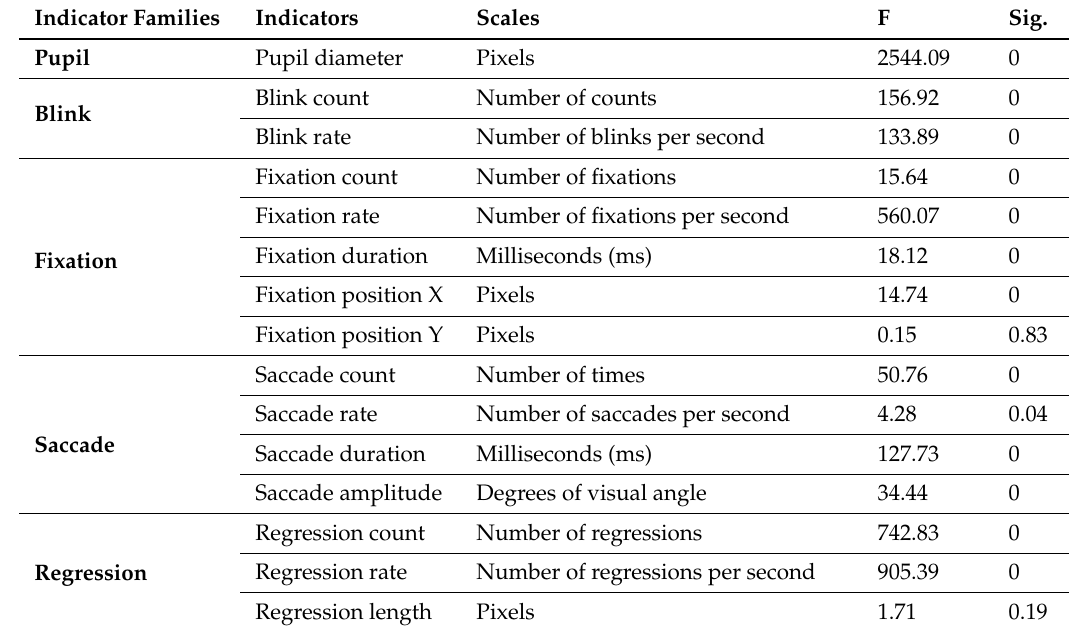
Table 1. Sensitive eye-tracking